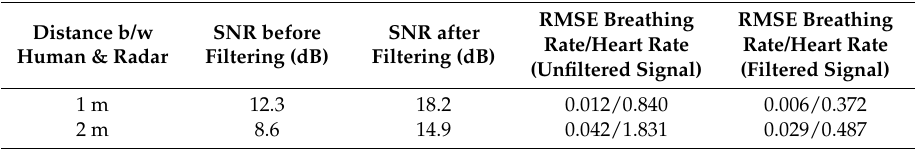
Table 2. RMSE for vital signals with different input signal-to-noise ratio (SNR) values.